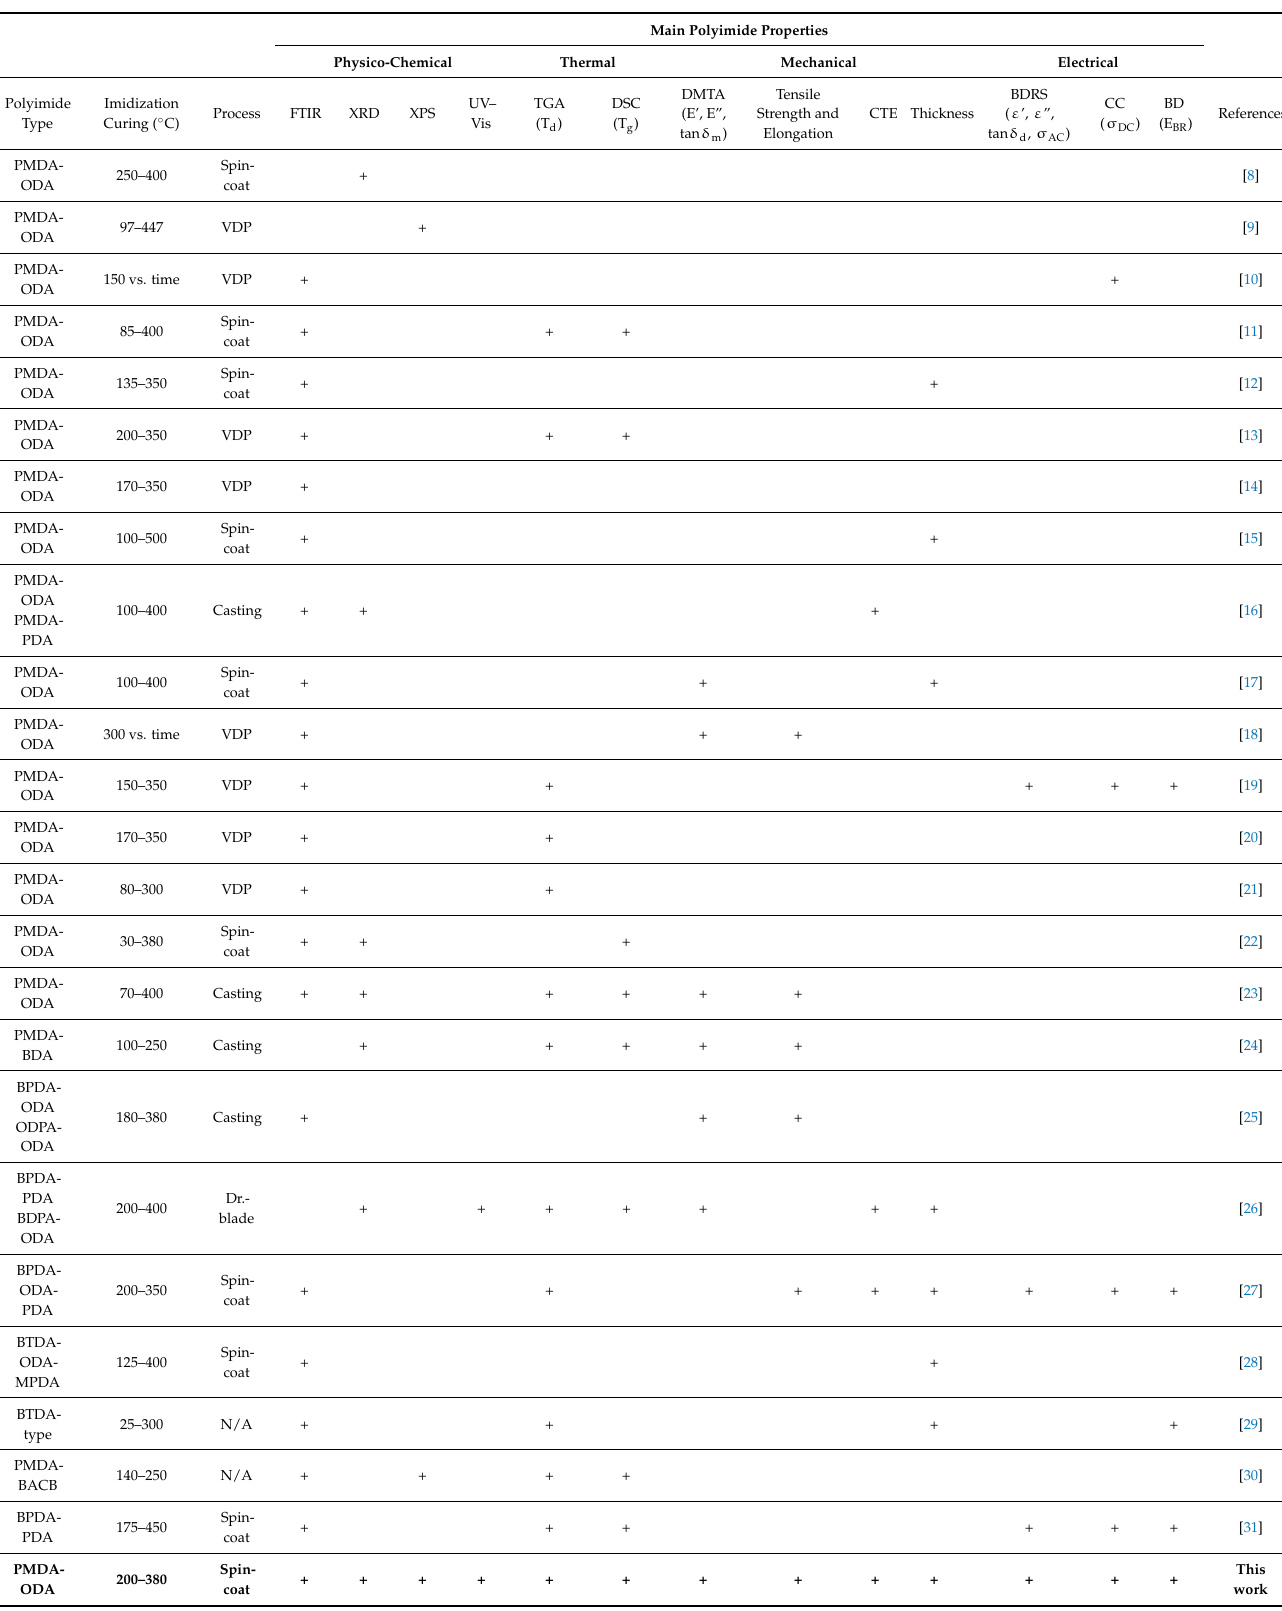
Table 1. State-of-the-art of previous studies on the imidization temperature effects on polyimide physico-chemical, thermal, mechanical and electrical properties with respect to the present work. The ‘+’ means that the technique has been used in the referenced